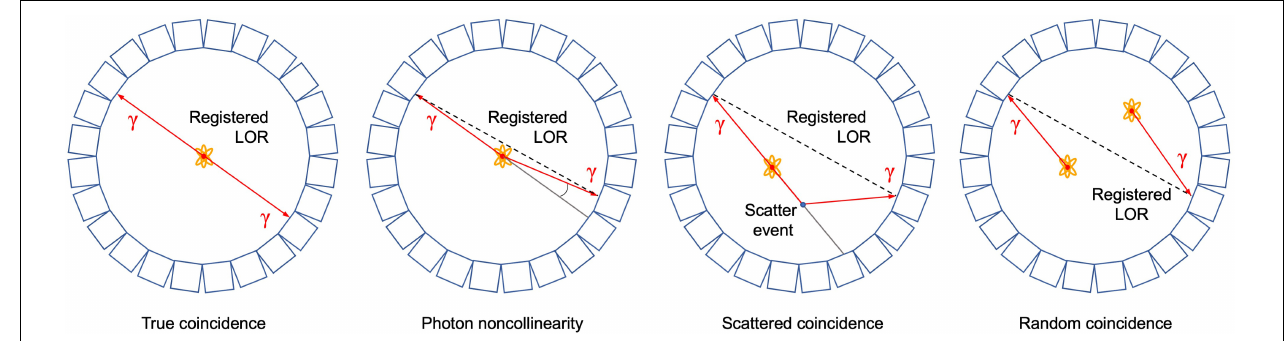
FIGURE 4 | Schematic representation of a true coincidence event and several image degrading effects in positron emission tomography, i.e., photon noncollinearity, scattered and random coincidence. In each case, the resulting line of response (LOR) that is registered by the detectors is shown.